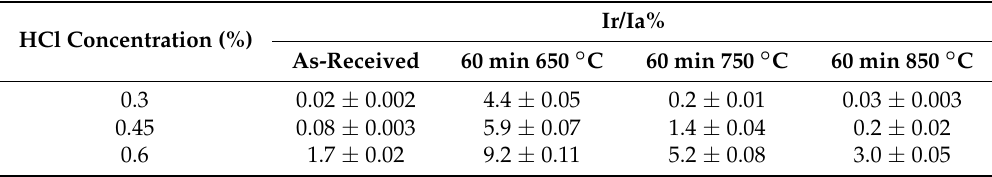
Table 3. Ir/Ia% ratios and standard deviations in 33% H 2 SO 4 solution with different HCl concentrations, at 20 ◦ C. Double loop electrochemical potentiokinetic reactivation (DL-EPR) tests performed on DSS 2304, both as-received and 60-min aged at 650, 750 and 850 ◦ C.